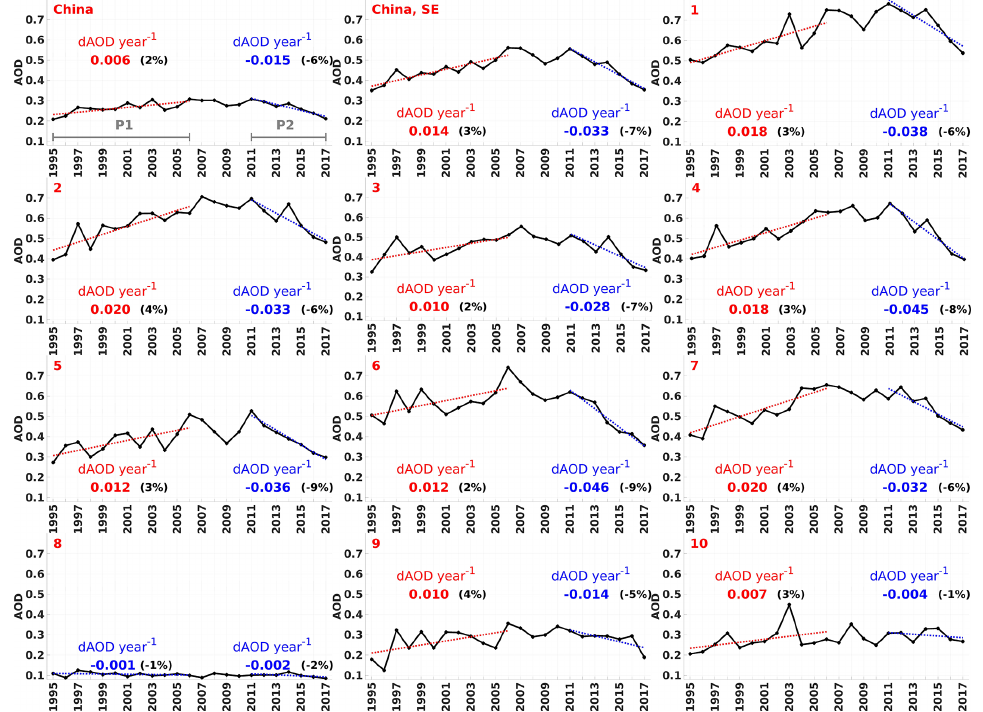
Figure 9. Time series (black line) of the annually averaged AOD combined from ATSR and MODIS for China, SE China and 10 selected regions (see Fig. 2, corresponding red numbers in the left upper corner of each region). Results for the linear fitting of AOD are shown for two periods, P1 (1995–2011) and P2 (2011–2017), marked using grey lines in upper left subplot. Fitting lines (dashed lines) and AOD tendencies (numbers) are shown when the AOD tendency was positive (red) and when AOD tendency was negative (blue). The corresponding relative AOD tendencies for each fit are shown in brackets (in black;